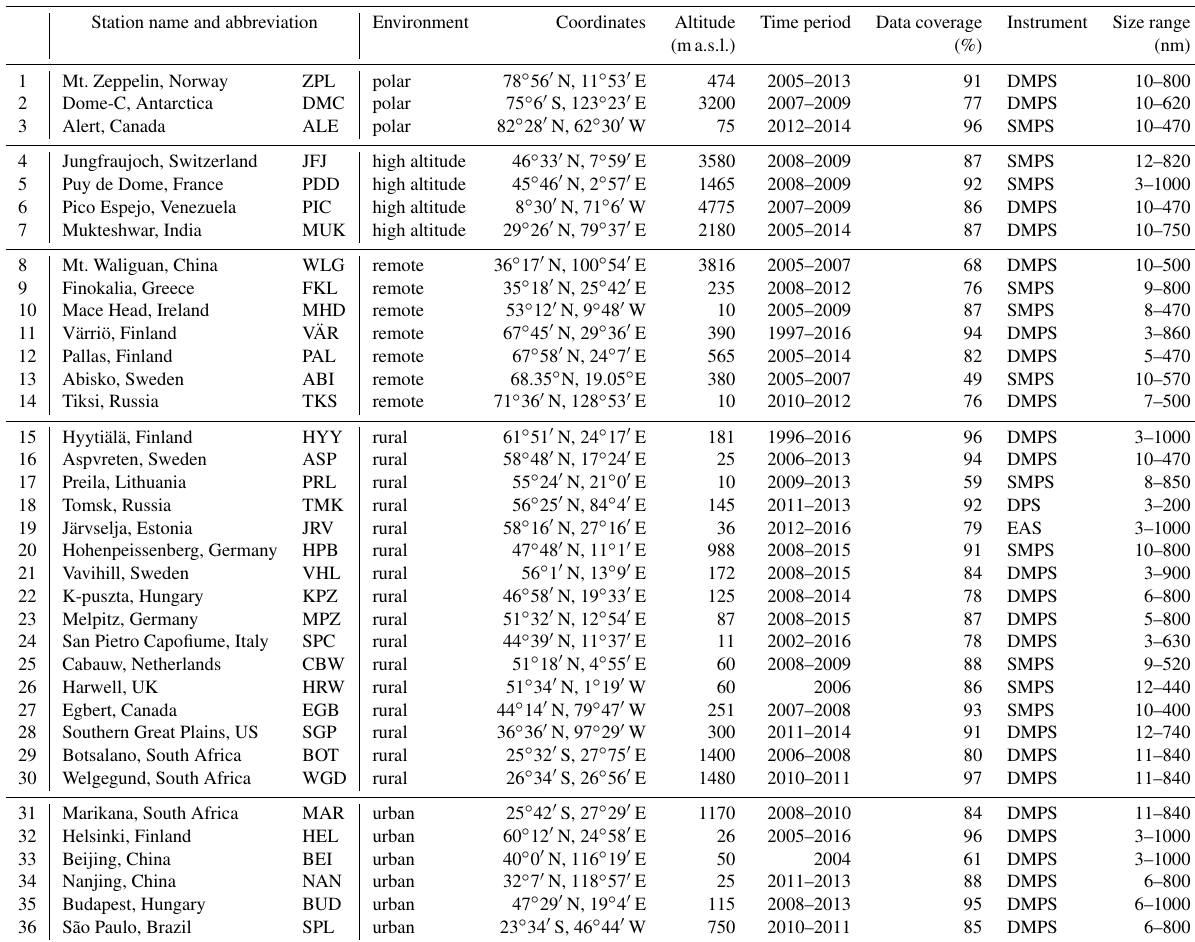
Table 1. List of the measurement sites included in this study, the station name abbreviation used to identify the sites in all the figures, station environment type, coordinates and altitude above sea level (a.s.l.), time period from which data were analyzed, availability of data (percentage of days with available data between start and end of the studied time period), instrumentation, and the particle size range. The instruments used to measure aerosol number size distributions were a differential mobility particle sizer (DMPS), scanning mobility